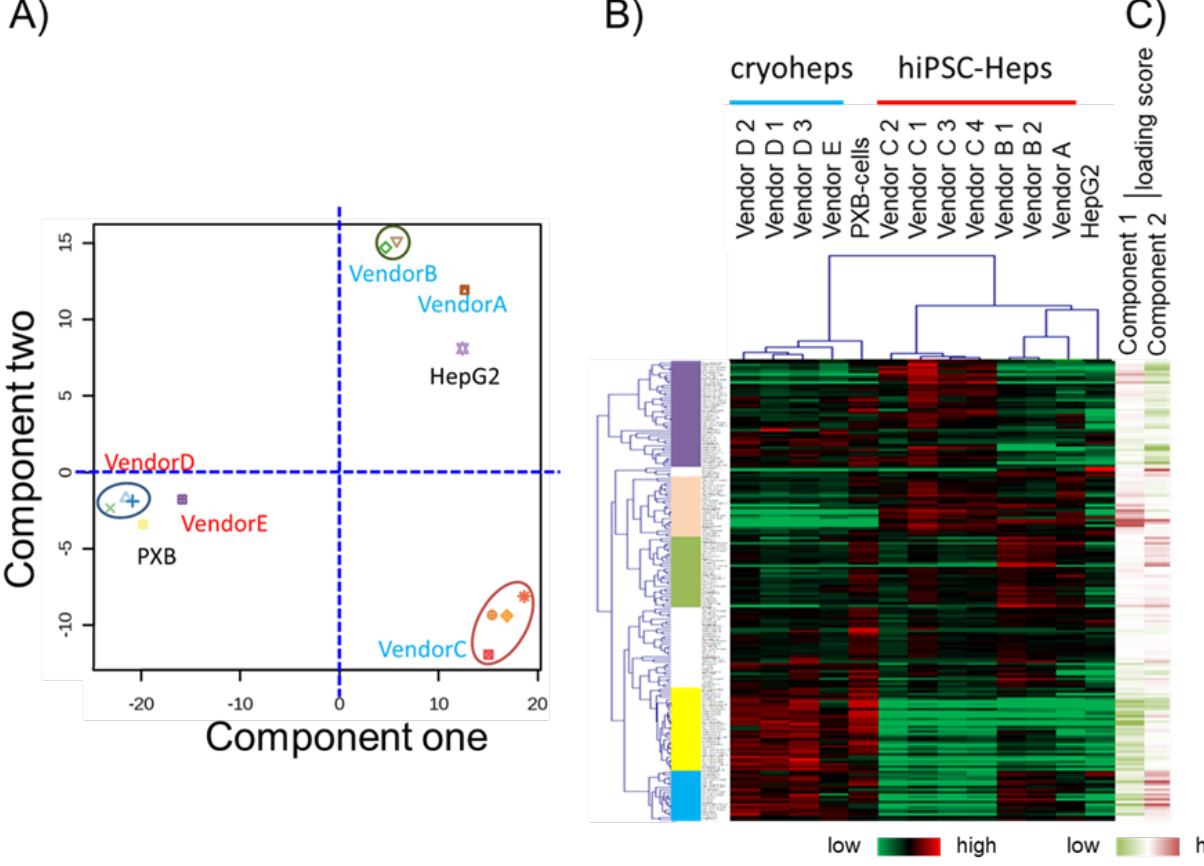
Figure 4. Global characterization of the cell types based on the gene expression data from the Focused microarray assay. ( A ) Principal component analysis (PCA) object. The horizontal axis represents the loading scores for PC1, and the longitudinal axis represents the loading scores for PC2. ( B ) Heatmap patterns and hierarchical clusters. ( C ) The lines show the loading scores for PC 1 and 2. Red lines exhibit plus scores, and green lines exhibit minus scores. Branches comprising genes that tend to have the same loading score are exhibited by color. Orange branches comprise genes with a high loading score for PC1. Yellow branches comprise genes with a low loading score for PC1. Green branches comprise genes with a high loading score for PC2. Purple branches comprise genes with a low loading score for PC2. Blue branches comprise genes with a low loading score for PC1 and a high loading score for